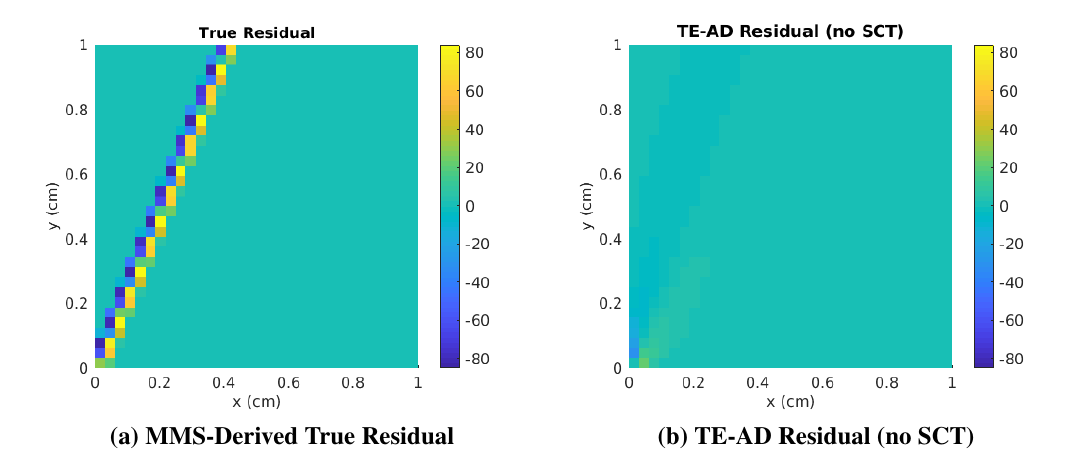
Figure 4: Cell-Wise Residuals for a Single Ordinate